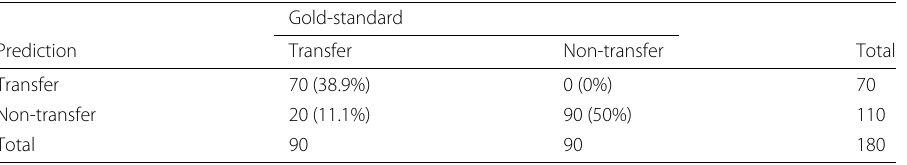
Table 6 Confusion matrix of image & text similarity comparing Gold-standard Prediction